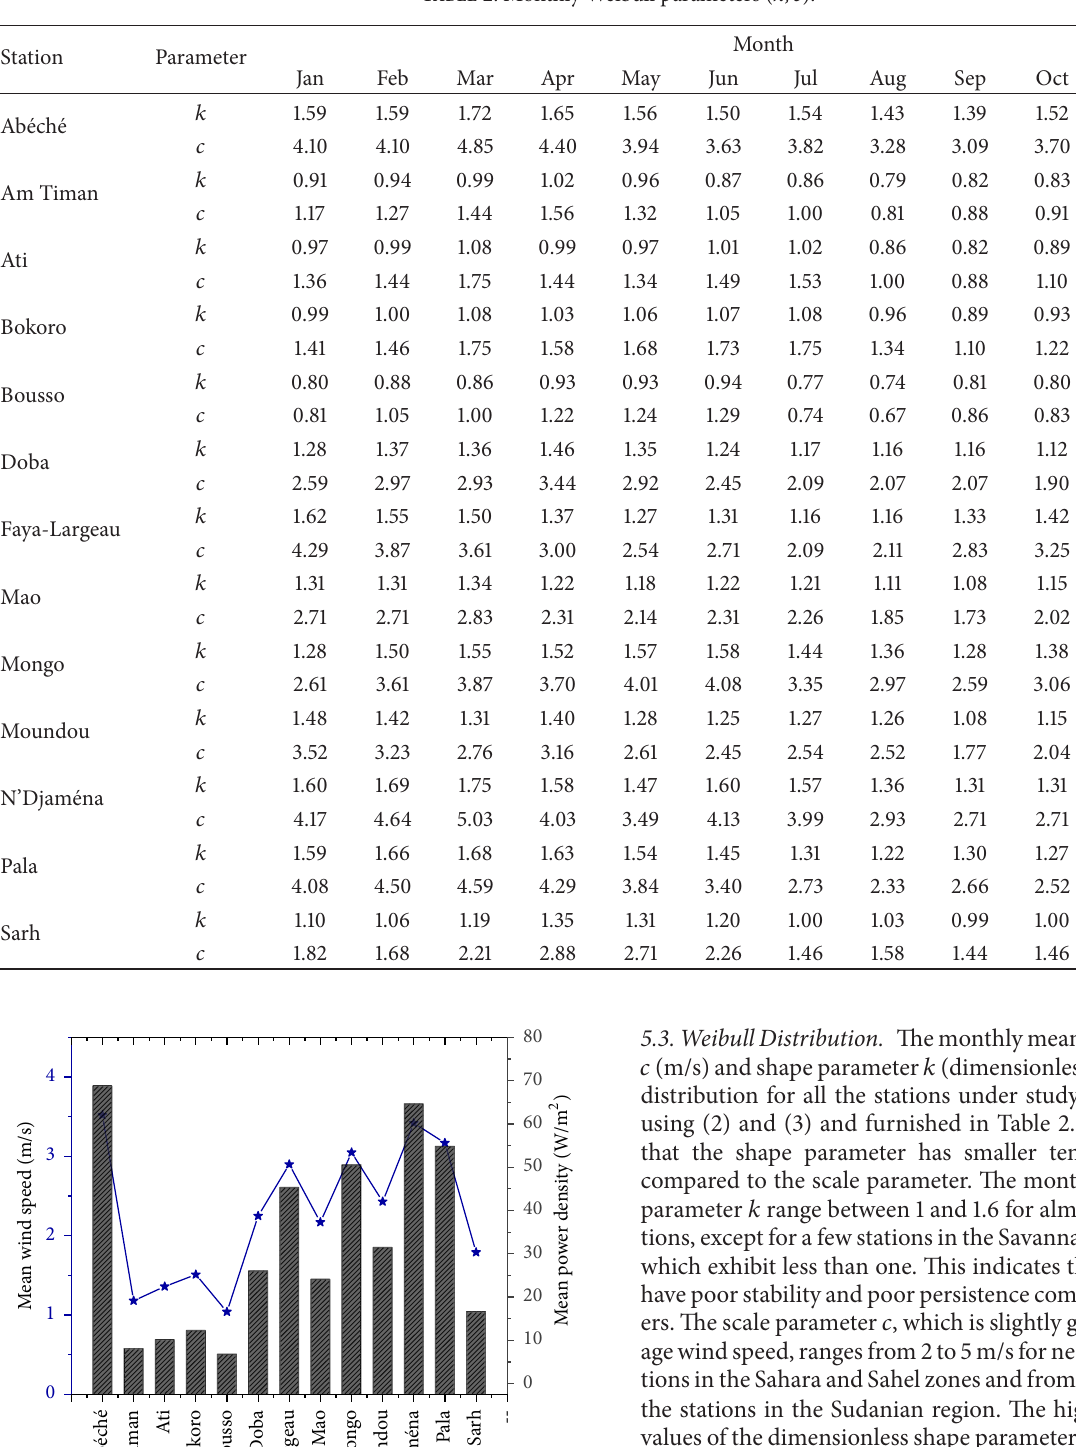
Table 2: Monthly Weibull parameters ( 𝑘, 𝑐 ).